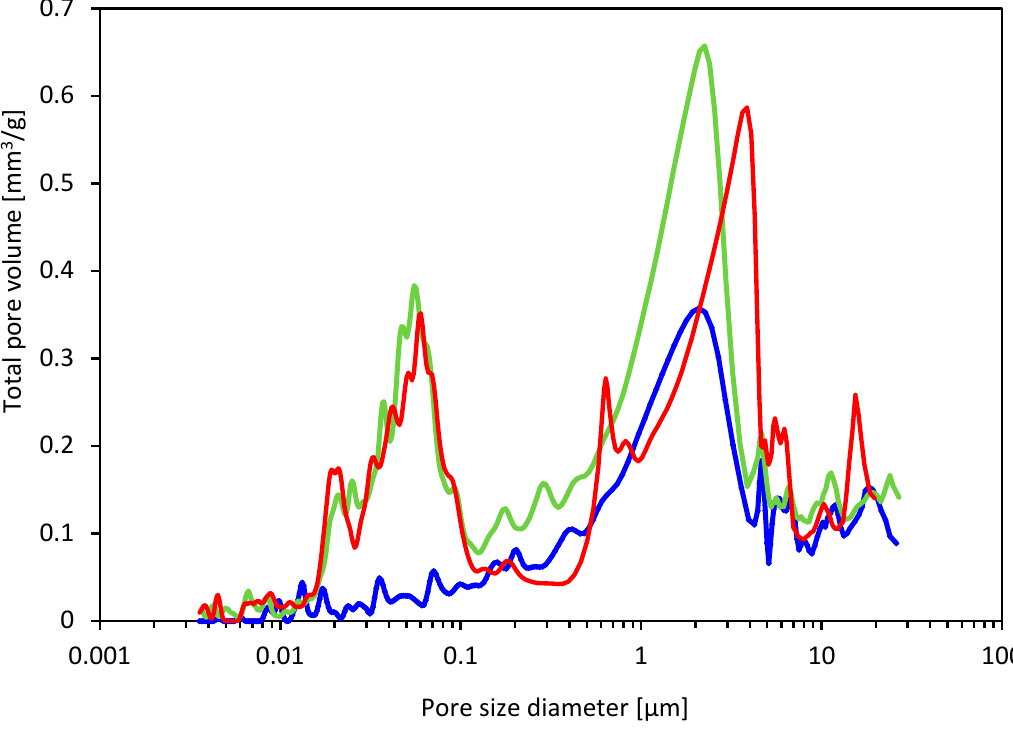
Figure 12. Magnesite from Braszowice. Pore volume distributions as a function of their diameter ( – natural sample; – after the decarbonation process; – after the sulfation process).